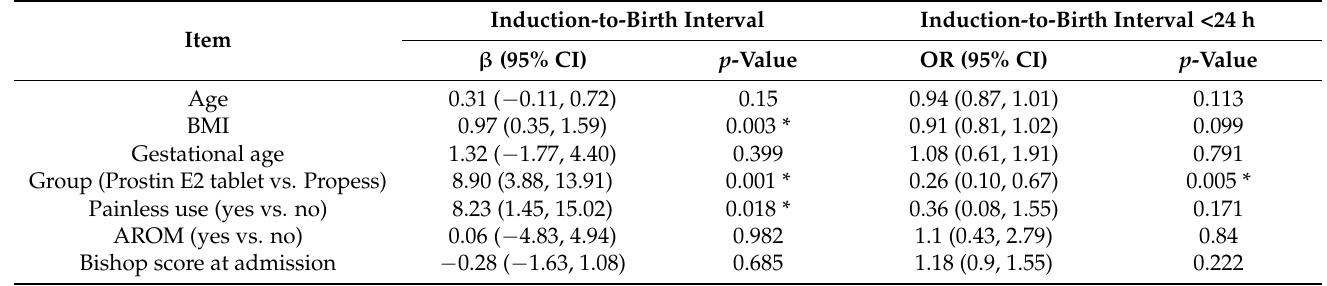
Table 4. Factors associated with the induction-to-birth interval and induction-to-birth interval <24